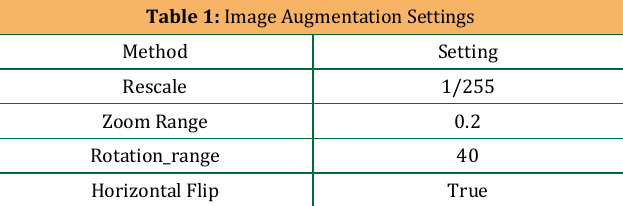
Table 1: Image Augmentation